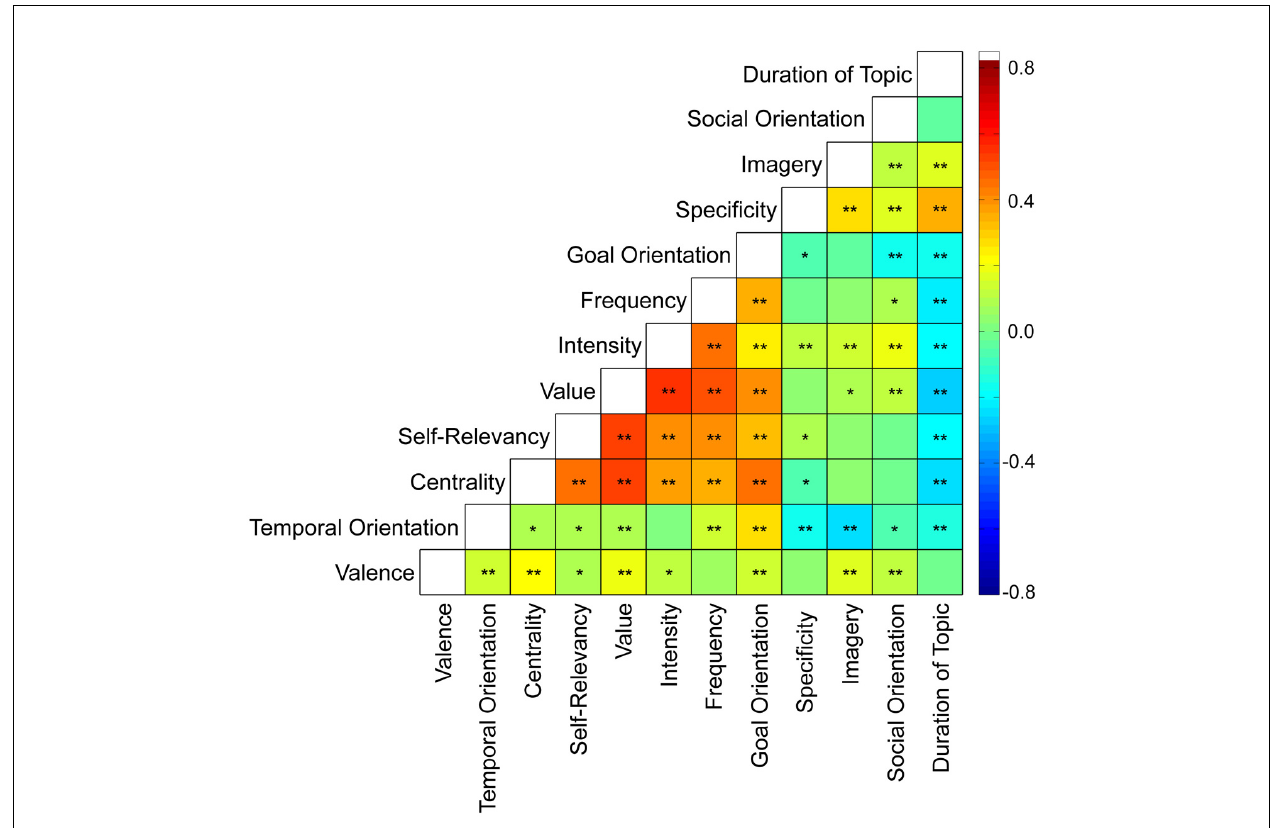
higher scores for Duration ofTopic correspond to thoughts concerning topics or events lasting shorter durations. * p < 0.05, ** p < 0.0008 (alpha corrected for multiple comparisons using the Bonferroni